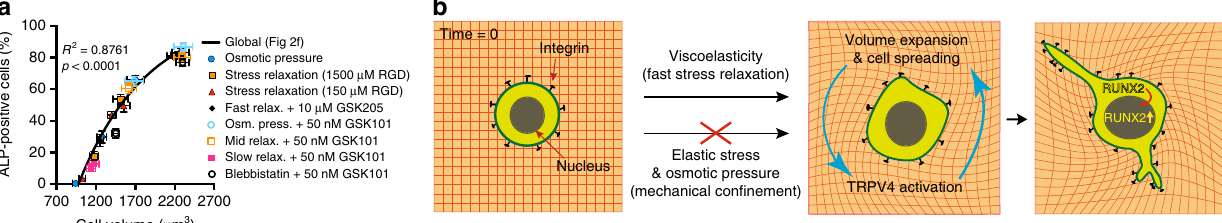
Fig. 7 Volume expansion and TRPV4 dictate cell fate response to viscoelasticity. a Percentage of ALP-positive cells as a function of cell volume for all the different conditions probed in this study appear to follow a single relationship. b Cartoon schematic of proposed mechanism. MSCs cultured in viscoelastic matrices physically remodel their microenvironment to expand cell volume associated with spreading. The volume expansion is interdependent with TRPV4 activation, which enhances osteogenic differentiation of MSCs by increasing nuclear localization of RUNX2. In this process, mechanical con fi nement by either elastic stress or osmotic pressure of surrounding environment restricts cell volume expansion, impeding osteogenic